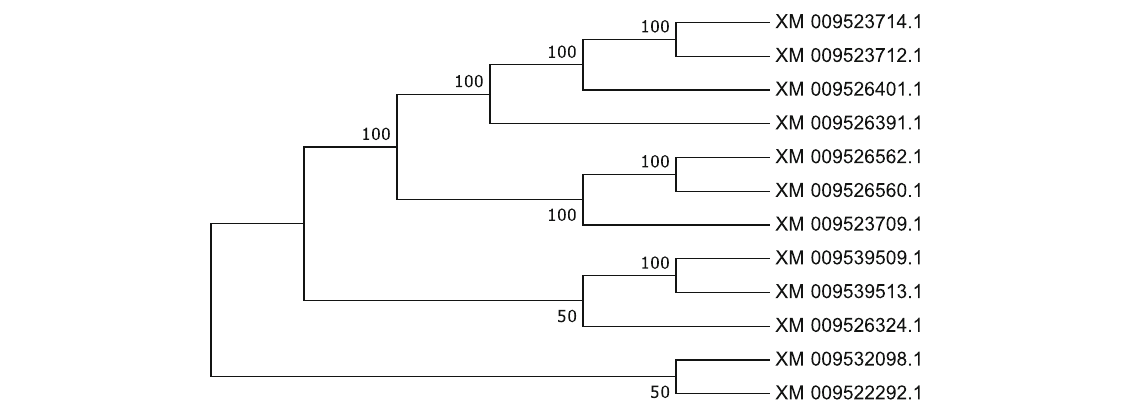
Fig. 2 Maximum Parsimony analysis of P. sojae PL3-coding gene sequences. The evolutionary history was inferred using the Maximum Parsimony method and the consensus tree inferred from two most parsimonious trees is shown. The percentage of parsimonious trees in which the associated taxa clustered together are shown next to the branches. The analysis involved 12 nucleotide sequences. Codon positions included in the analysis were 1st+2nd+3rd+ Noncoding. There was a total of 674 positions in the final dataset and all positions containing gaps and missing data were eliminated. Tree shown is representative of the topology generated by the Neighbor Joining and Maximum Likelihood methods using the same dataset. Evolutionary analyses were conducted in MEGA7